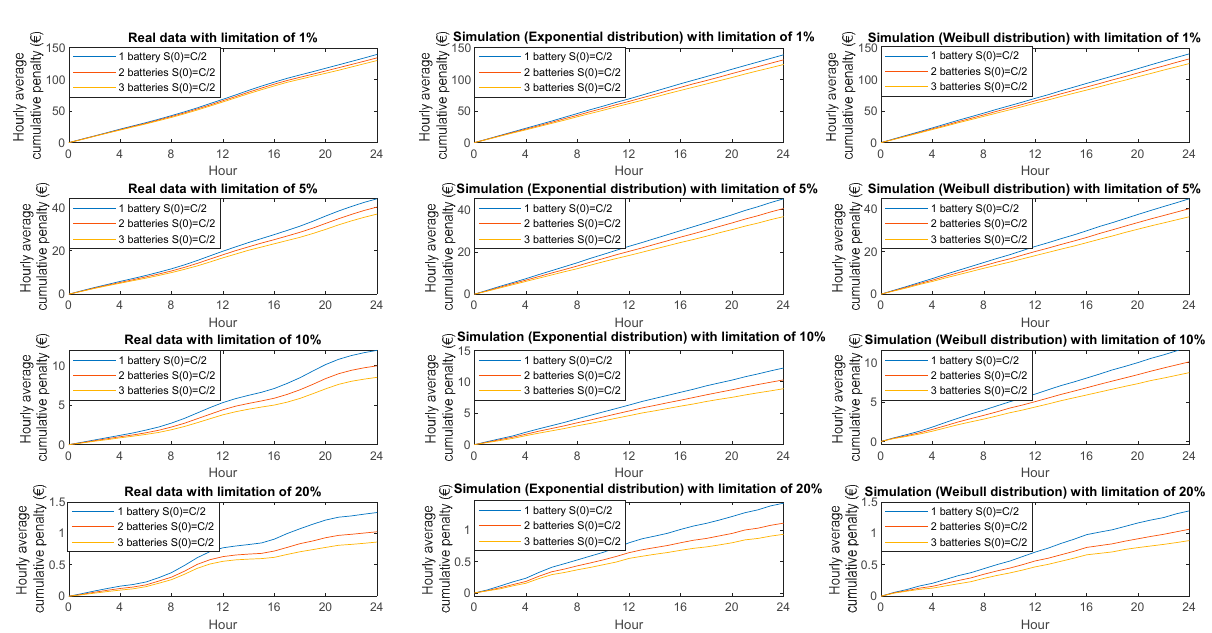
Figure A1. Hourly average cumulative penalty in 1 day with the ramp-rate percentage limitations of 1%, 5%, 10% and 20%.